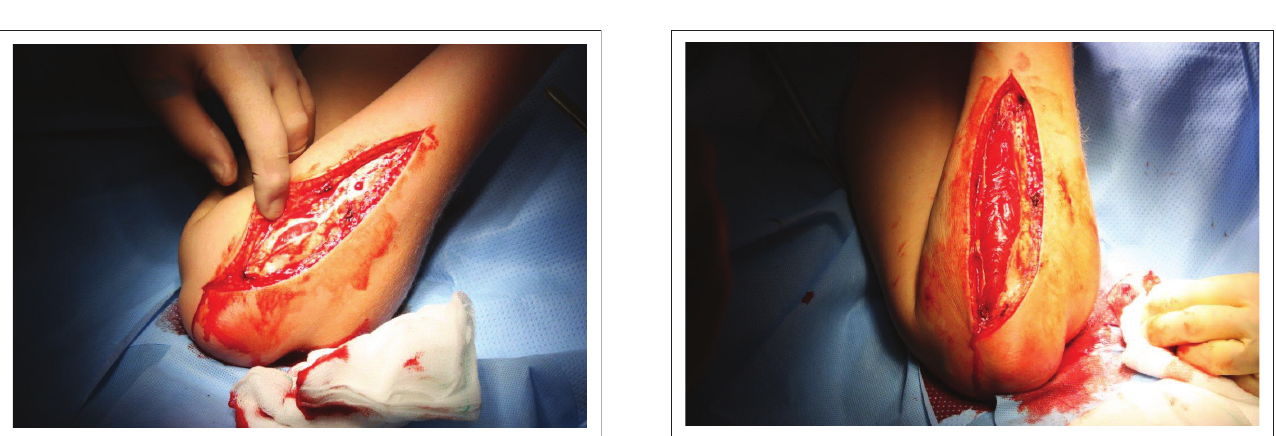
FIGURE 4: (a) Axial fat-suppressed, T2-weighted magnetic resonance imaging of the left forearm , pre-exercise demonstrates iso-intensity of muscle groups. Note again the normal calibre of intramuscular vessels; (b) Axial fat-suppressed, T2-weighted magnetic resonance imaging of the left forearm, post-exercise. Arrows show hyperintensity of the muscle groups with effaced intramuscular vessels. The yellow arrow points to the flexor carpi radialis (FCR); the blue arrow points to the flexor pollicis longus (FPL); the red arrow points to the extensor compartment, including abductor pollicis longus (APL), extensor pollicis longus (EPL) and extensor digitorum communis (ED).